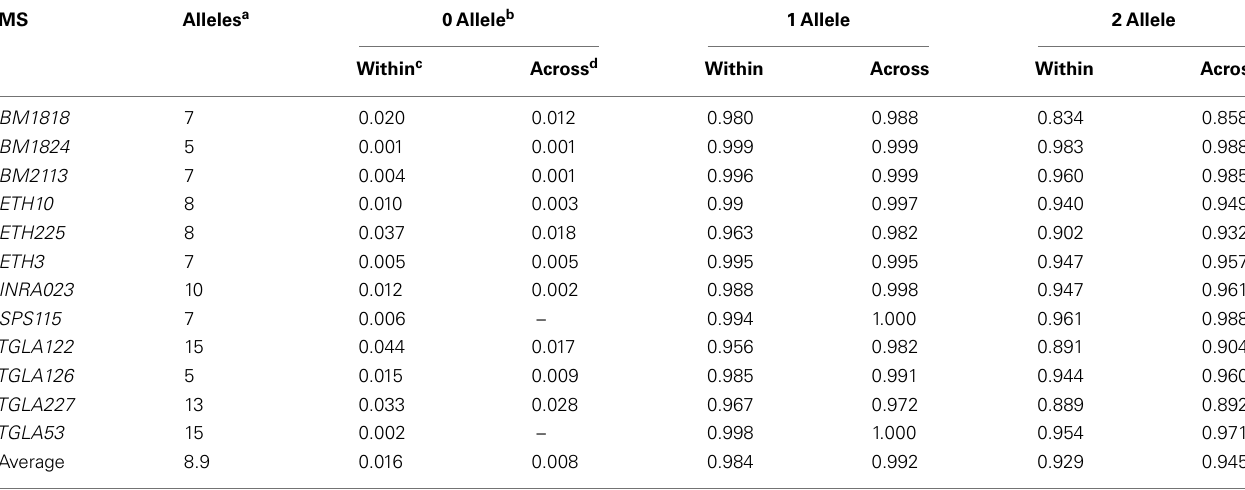
Table 4 | Percent of 1,301 individuals with haplotypes imputed to microsatellite (MS)